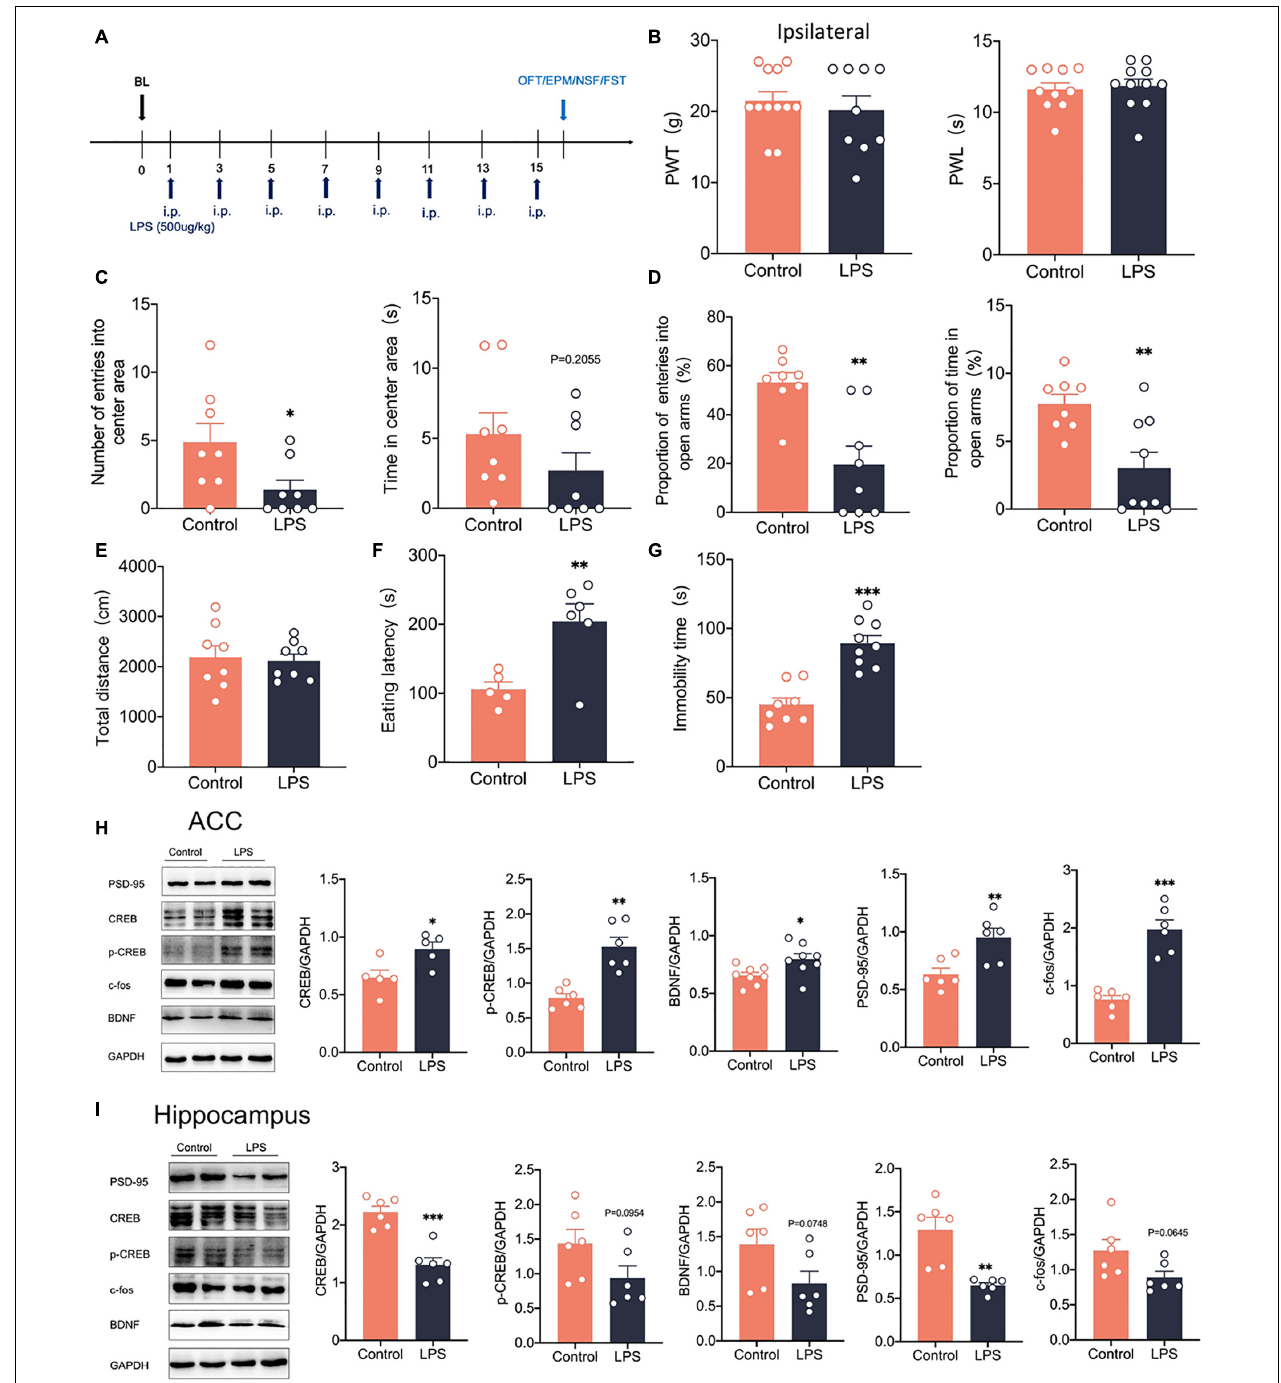
FIGURE 9 | Intraperitoneal administration of LPS induced anxiodepression like behaviors in rats and activated the CREB/BDNF signaling pathway in the ACC. (A) Lipopolysaccharide (LPS) was injected intraperitoneally (i.p.) every 2 days for 14 days. (B) Intraperitoneal administration of LPS did not affect PWT and PWL in rats ( n = 9 rats/group). (C) Intraperitoneal administration of LPS reduced the number of entries into the center area, but not the time in the center area in rats ( n = 9 rats/group). (D) Intraperitoneal administration of LPS reduced the proportion of entries into the open arms and the proportion of time in the open arms in rats ( n = 9 rats/group). (E) Intraperitoneal administration of LPS did not alter the locomotor activity of the rats ( n = 9 rats/group). (F,G) Intraperitoneal administration of LPS increased the eating latency (F) and the immobility time (G) in rats ( n = 9 rats/group). (H) Intraperitoneal administration of LPS activated the CREB/BDNF pathway in the ACC ( n = 6 rats/group). (I) Intraperitoneal administration of LPS Suppressed the CREB/BDNF pathway in the hippocampus ( n = 6 rats/group). ∗ P < 0.05, ∗∗ P < 0.001, ∗∗∗ P < 0.0001 for Control vs. LPS.